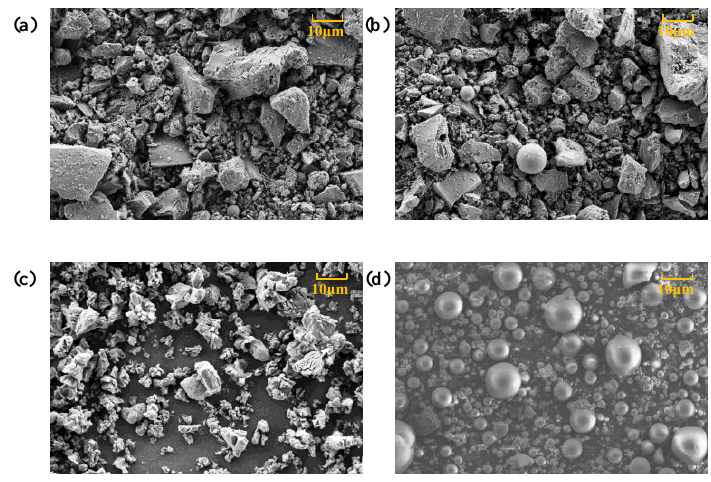
Figure 3. SEM images of ( a ) SC, ( b ) C Ṡ A, ( c ) quicklime, and ( d ) FA (Mag = 3000×).